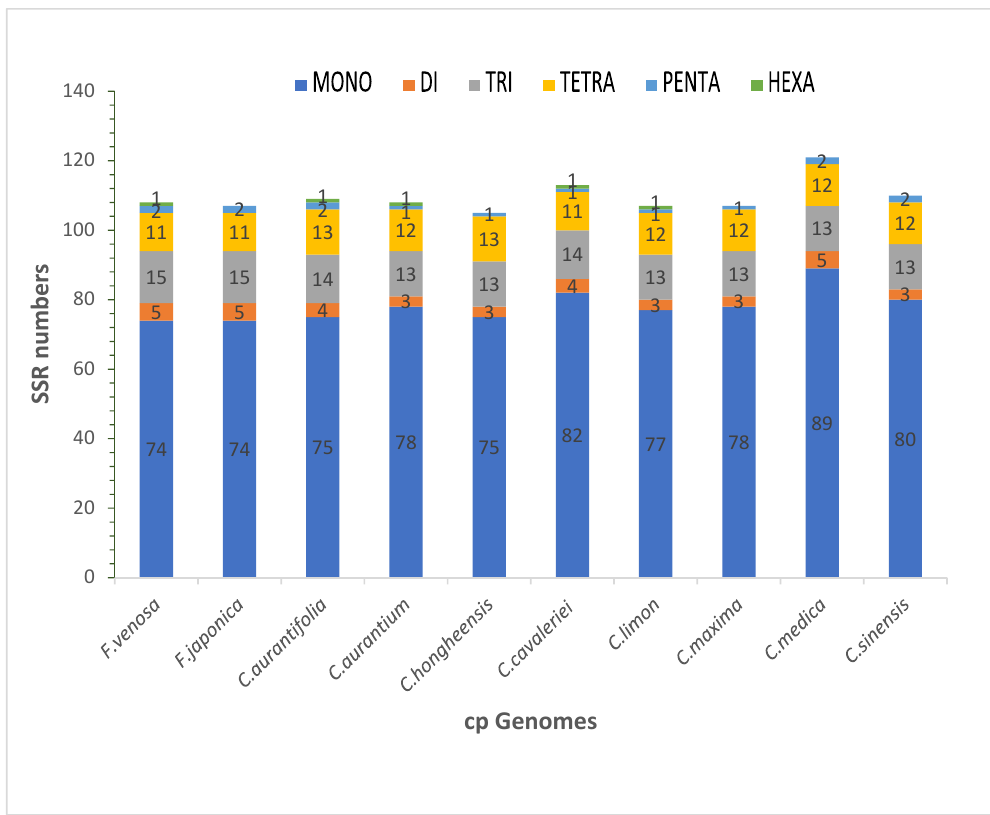
Figure 4. Analysis of SSRs in ten Rutaceae chloroplast genomes. (The number of different SSRs detected in 10 genomes). The Mono-, Di-, Tri-, Tetra-, Penta-, and Hexa- represents the nucleotide motifs of the SSRs present in the 10 species genome.